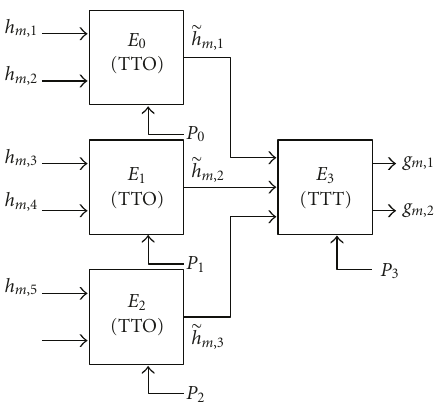
Figure 4: Tree structure overview of the morphing of five of the ten BRIR responses h m , i . Note the similarity to the encoding process depicted in the right panel of Figure 2. Also note that the LFE channel is not taken into account in the HRTF filtering, and thus (cid:21) h = h m ,3 m ,5